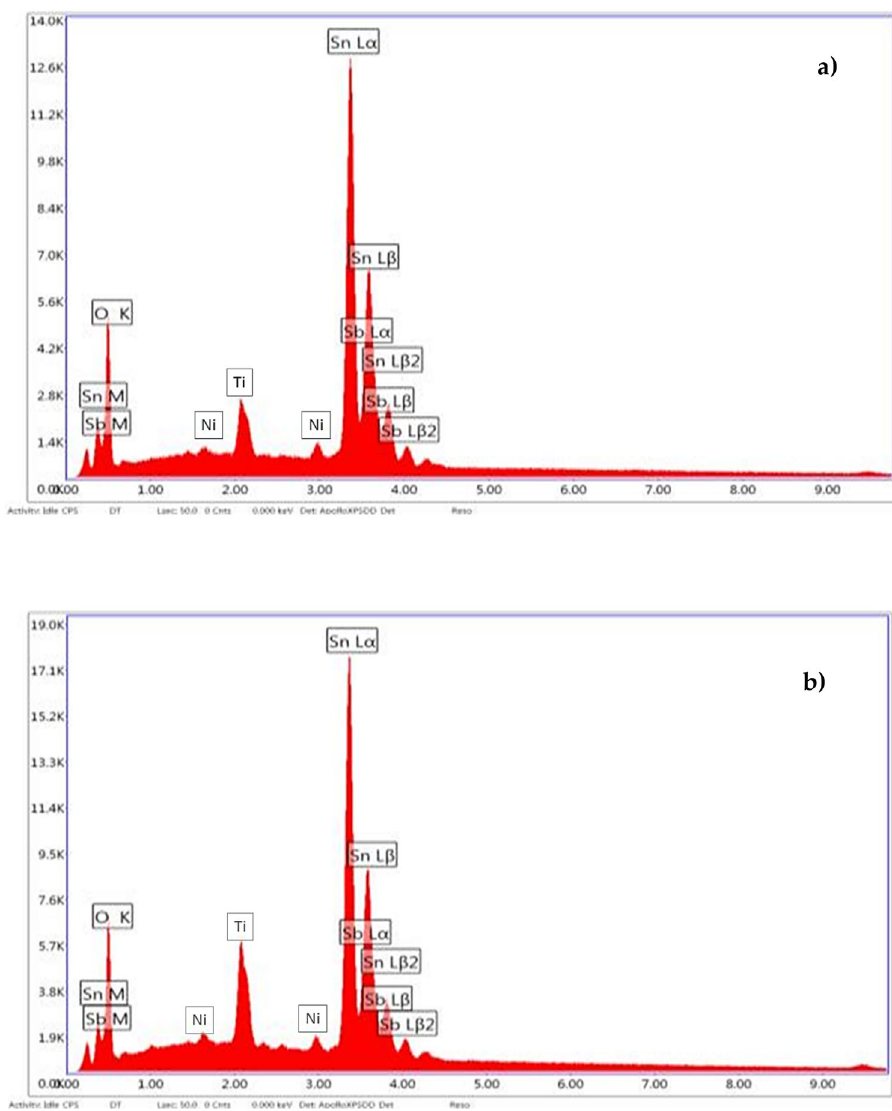
Figure 9. EDS spectra of the anodes ( a ) unused anode (clean product), ( b ) used anode (contaminated product).